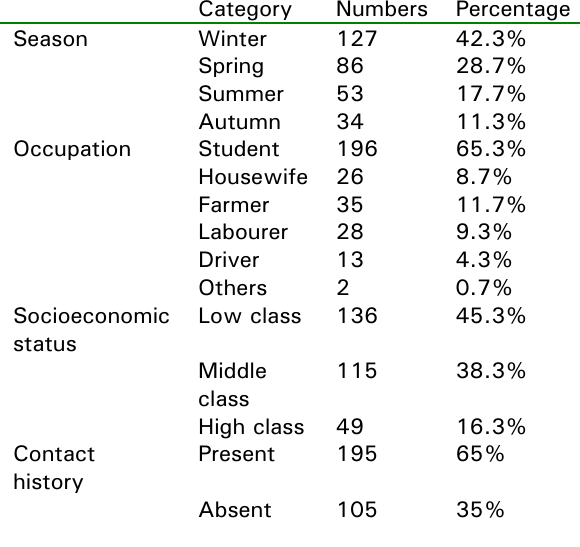
Table 2: Distribution of scabies patient by various demographic features